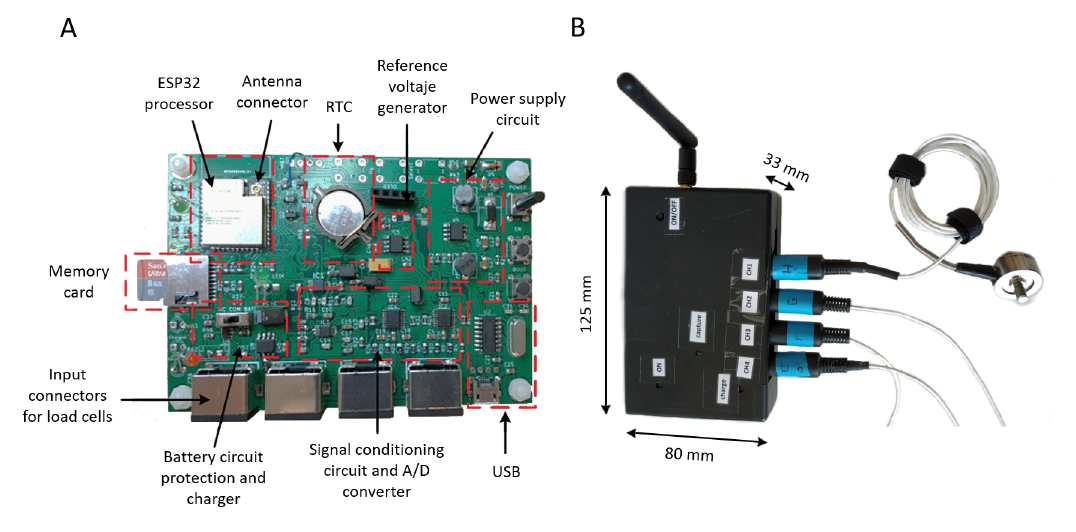
Figure 3. Image of the data acquisition system: ( A ) hardware board; ( B ) packaging design and its